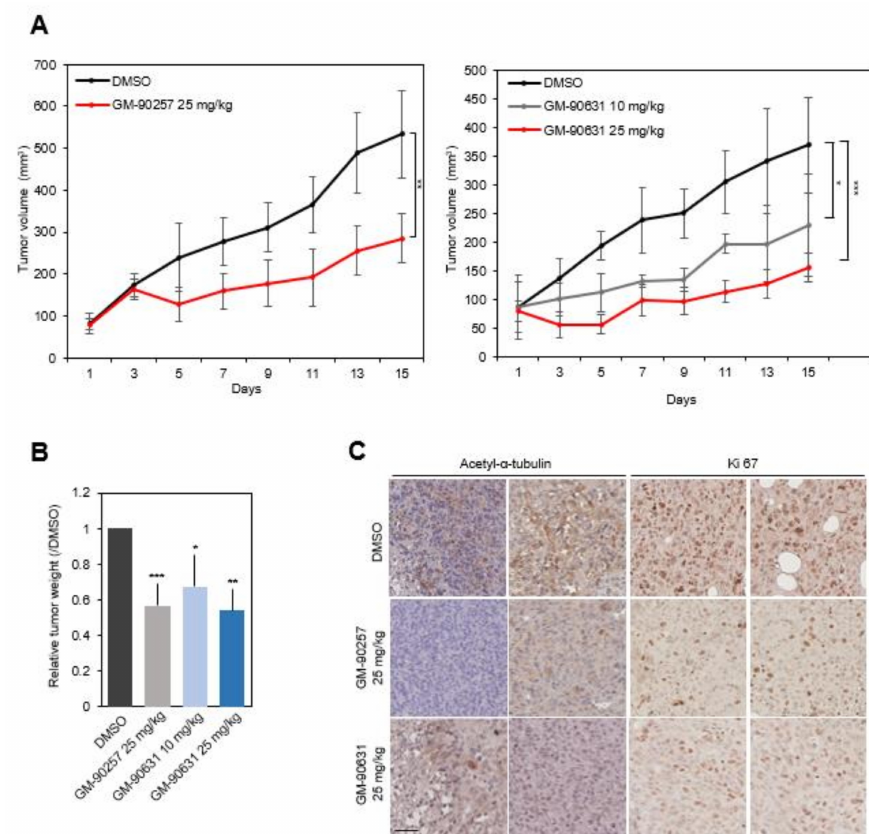
Figure 5. Inhibition of TNBC progression in vivo by GM-90257 and GM-90631. ( A ) MDA-MB-231 cells were injected into the mammary fat pads of NOD / SCID mice. The mice were randomly divided into two groups: control (DMSO) and 25 mg / kg GM-90257 ( n = 5 per group, left graph). Each drug was intraperitoneally (i.p.) administered once every 2 days for 15 days. The right graph shows the experimental results for GM-90631, and the mice were randomly divided into three groups: control (DMSO), 10 mg / kg GM-90631, and 25 mg / kg GM-90631 ( n = 5 per group). The graphs show the tumor volume growth for 15 days, and the bars in the graphs indicate the standard